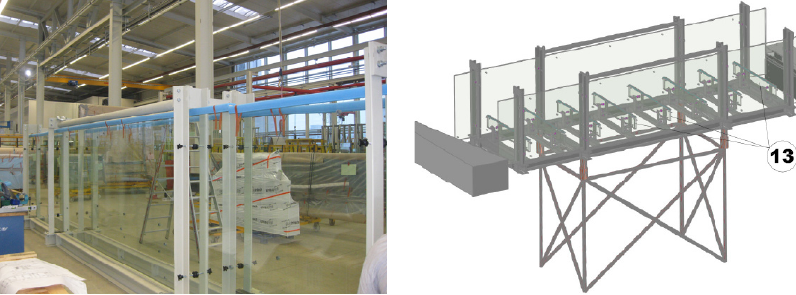
Figure 10: Erection sequencing as provided by Gartner Steel and Glass GmbH.